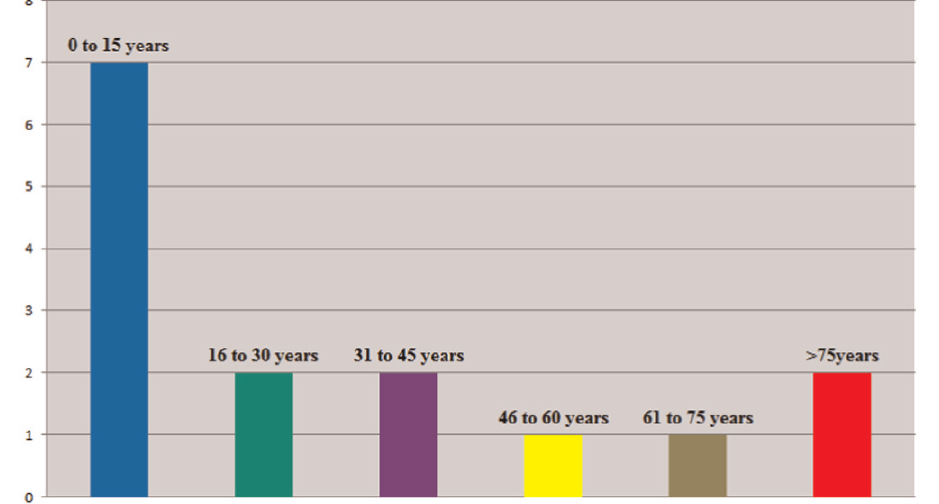
Figure 1 – Age distribution of septic arthritis